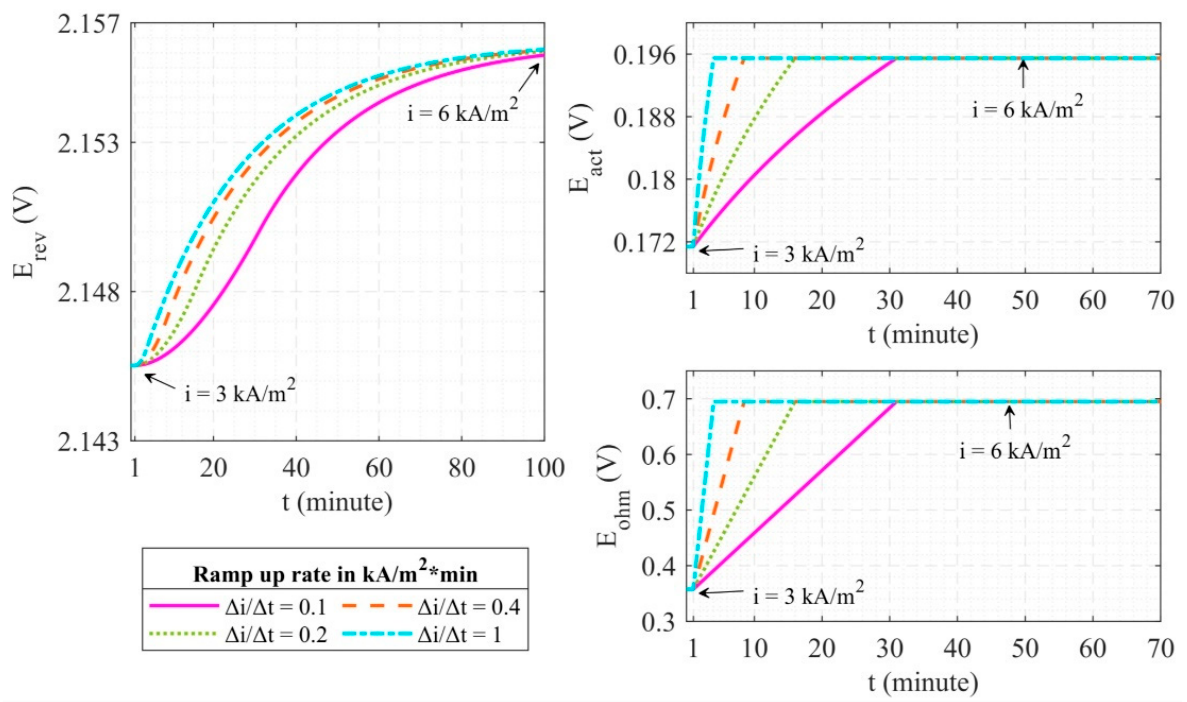
Figure 9. Temporal behavior of the cell voltage components to ramp up from 3 to 6 kA m − 2 at time, t = 1 min, with ramp rates of 0.1, 0.2, 0.4 and 1 kA m − 2 min − 1 . Left: reversible potential. Top-right: activation overpotential. Bottom-right: ohmic overpotential. Operating conditions: temperature: T in an = T in cat = 85 ◦ C; electrolyte concentration: X in = 300 gL − 1 and W in = 31 wt%; inlet volumetric flow rate: Q an = 5 L min cat = 6 L min .